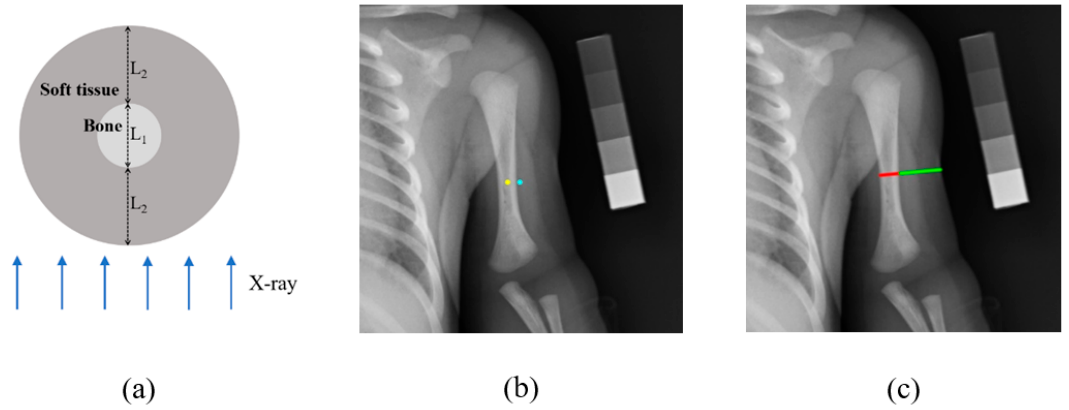
Figure 6. ( a ) The transverse view of the premature infant’s upper arm. ( b ) The yellow dot is a representative point of the bone area to be estimated, while the blue dot is a representative point of the soft tissue close to the bone. ( c ) Line segments are drawn on the X-ray image by an expert.